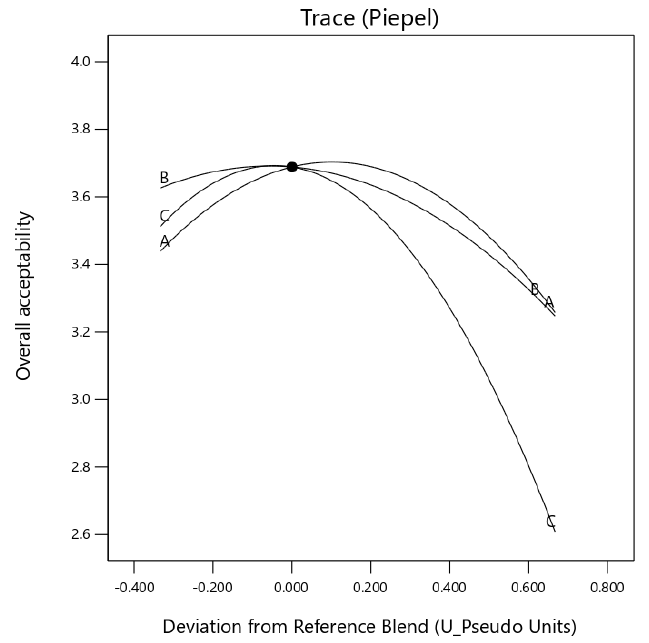
Figure 7. Trace (Piepel) plot for the effect of three components on overall acceptability (A: boiled egusi grit, B: flour and C hydrocolloid) on instant egusi soup.